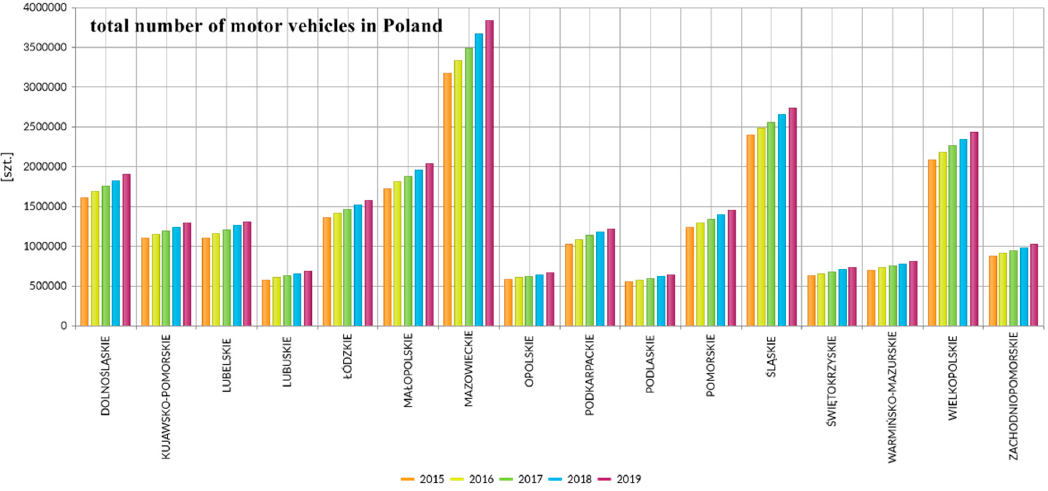
Figure 6. The total number of passenger vehicles registered in Poland at the end of 2019-24,360,166.